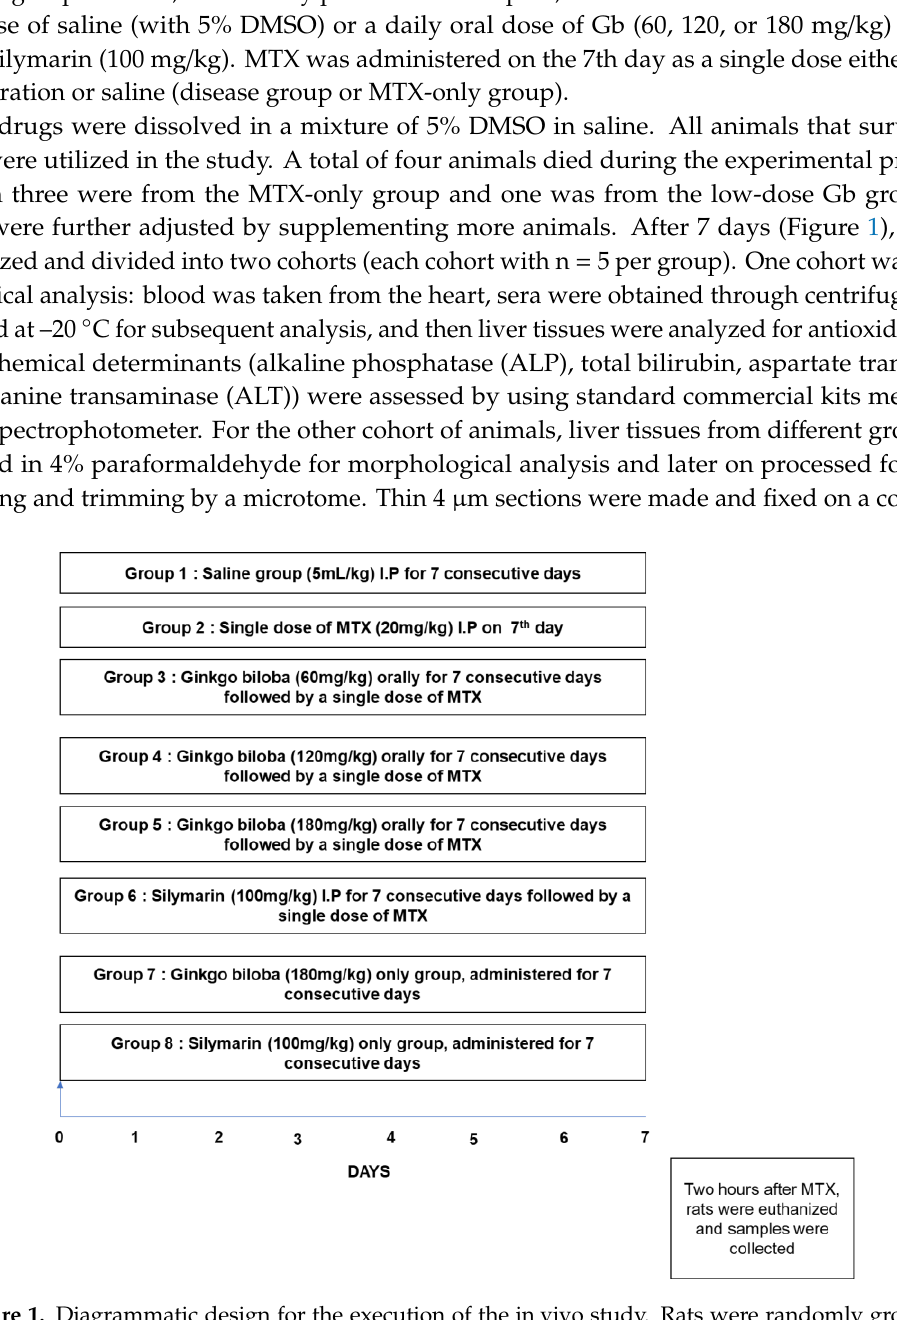
Figure 1. Diagrammatic design for the execution of the in vivo study. Rats were randomly grouped (n = 10 per group) as follows: (1) rats received a single daily dose of saline as a vehicle for 7 days; (2) rats were treated daily with saline and then on the 7th day received methotrexate (MTX) (20 mg/kg); (3) MTX + Ginkgo biloba (Gb) 60 mg, where rats received Gb (60 mg/kg) orally for 7 days and then on